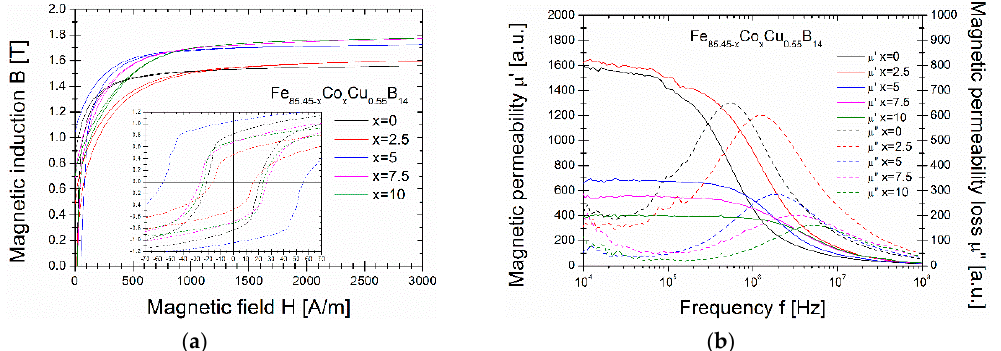
Figure 5. B First quarters of B(H) curves for annealed samples at 310 °C ( a ). Magnetic permeability µ’ and magnetic permeability loss µ” dependence in the function of frequency 10 4 –10 8 Hz for annealed samples at 310 °C ( b ).